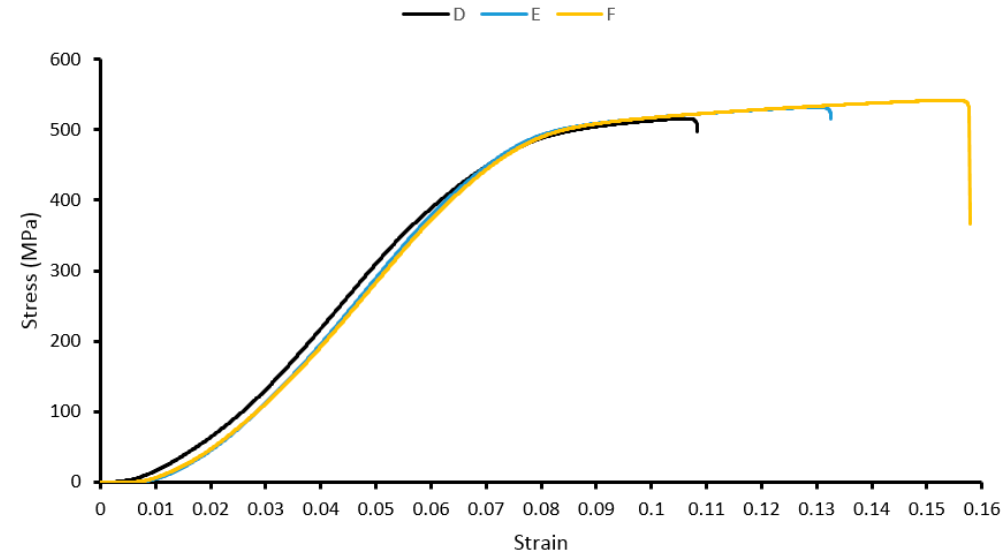
Figure 12. Customised specimen stress-strain plot.